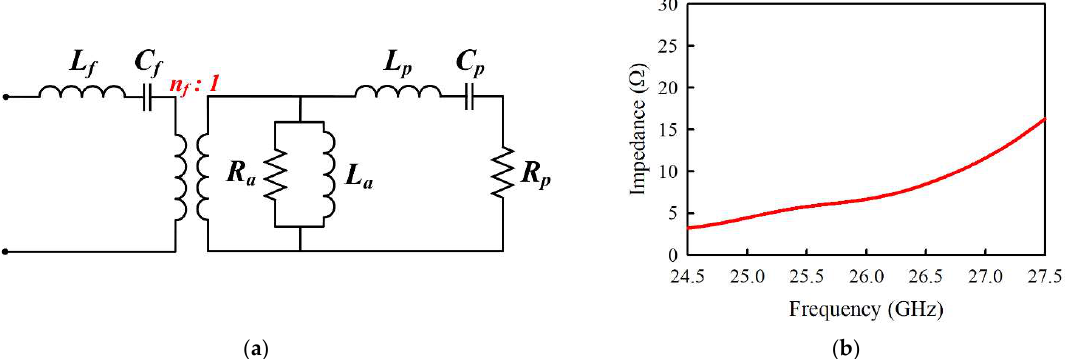
Figure 6. ( a ) Equivalent circuit of aperture-coupled antenna. ( b ) Impedance seen looking from the slot toward the patch within the operating band of the element antenna.